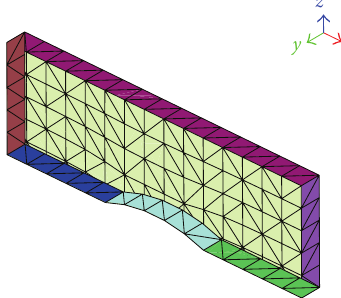
Figure 8: Curve connecting the top wall surfaces divided by the blade. The black dots are existing segment nodes, and the empty dots are the new nodes to be placed.